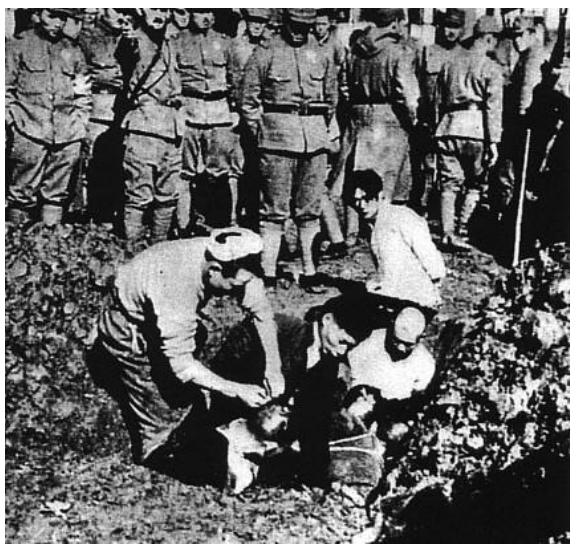
Figure 9. Burying Chinese prisoners alive. Source: Key- stone/Getty Images.